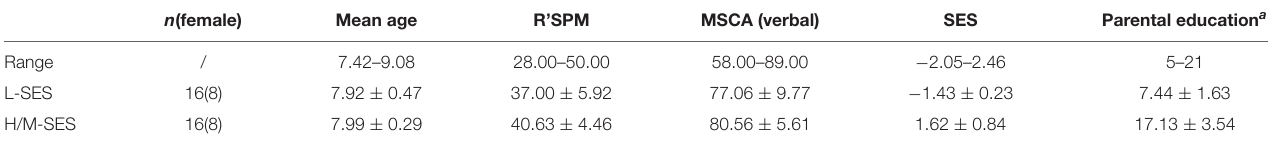
TABLE 1 | The general cognitive abilities and the demographic characteristics of the participants in different SES groups ( M ± SD ). n (female) Mean age